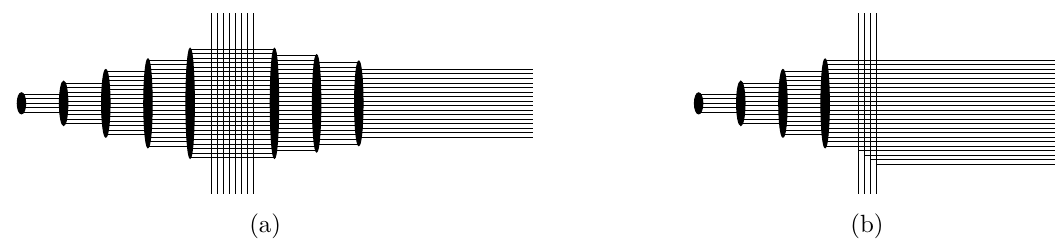
Figure 2. Left: BCFT quiver (3.1) for N 5 = 8 , K = 1 , with NS5-branes as filled ellipses, D3-branes as horizontal lines, and D5-branes as vertical lines. Right: BCFT quiver (3.7) for N 5 = 4 , K = 3